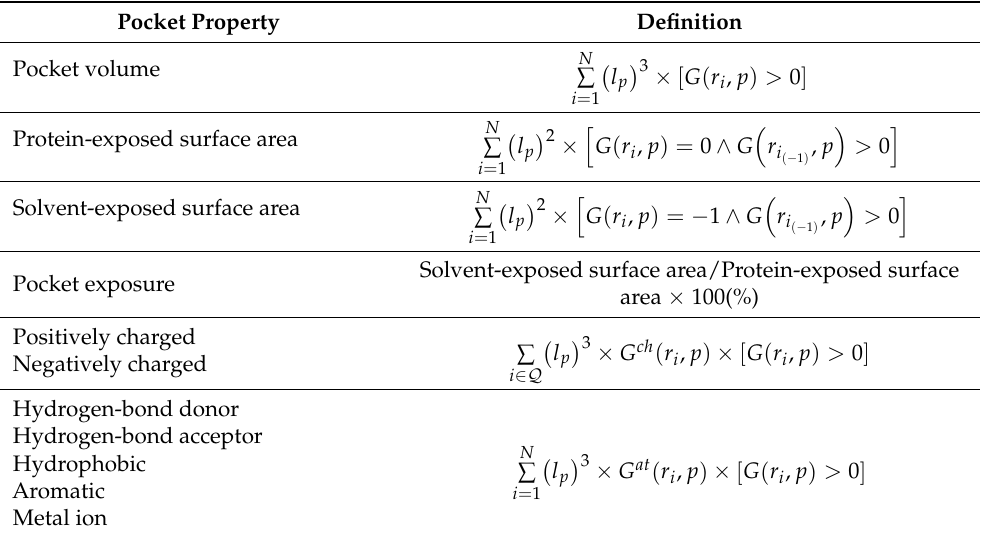
Figure 7. The selected residues around five sites of SARS-CoV-2 PLpro. Table 3. Definitions of the global descriptors generated in the TRAPP–pocket